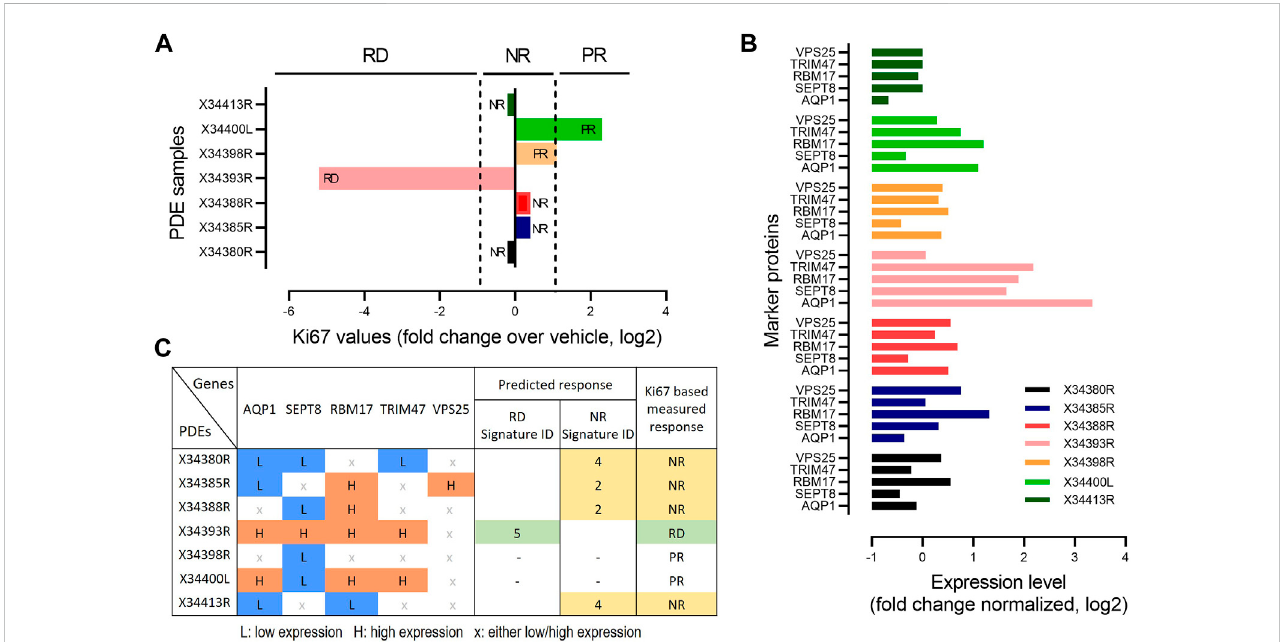
FIGURE 6 Validation ofbiomarker signatures. (A) Drugresponsiveness oftheseven PDEsto 17-AAGtreatment basedon foldchange in MKi-67 expression levels by the drug treatment relative to DMSO, measured by IHC. PDEs having > two-fold decrease in Ki-67 levels in response to the drug treatment compared to vehicle were de fi ned as RD; having < two-fold increase as PR); otherwise, NR as in Figure 2B. (B) mRNA expression levels of the 5 genes in our identi fi ed compactbiomarkerpanelsmeasuredbyqRT-PCRforeachPDEsample.ThemRNAexpressionwasnormalizedtoGAPDHandTUBA1B. (C) Predictionof drug response based on the identi fi ed biomarker expression signatures, compared against Ki67-based response classi fi cation. The expression levels of the marker genes were binarized based on the median values by applying 30% and 70% quantile cut-offs: 0 indicates low expression ( < 30% quantile) and 1 indicates high expression ( > 70%